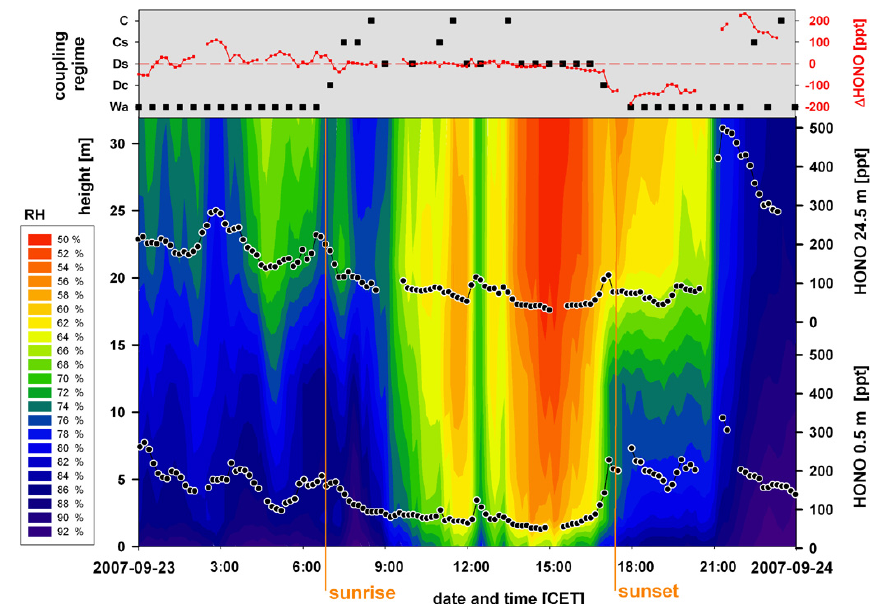
Fig. 7. Simultaneous HONO time series at 0.5m (lower graph, circles and lines) and 24.5m (upper graph, circles and lines), overlaid with a contour plot of the vertical profile of measured RH (colour-coded 50–92%) for 23 September 2007 at the “Waldstein-Weidenbrunnen” research site. Missing values in the HONO measurements are due to zero air measurements. Sunrise and sunset (inferred from j (NO 2 ) as a proxy for j (HONO) and global radiation measurements) are marked as vertical (orange) lines. The upper panel shows the mixing ratio differences between 24.5m and 0.5m ( 1 HONO) and the coupling regimes in the